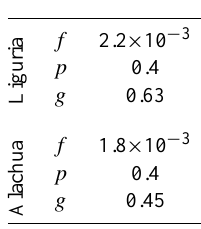
Table 3. Parameters of the Drossel-Schwabl Forest Fire Model; f is the probability of ignition, g is the probability of spread, p is the probability of re-growth.